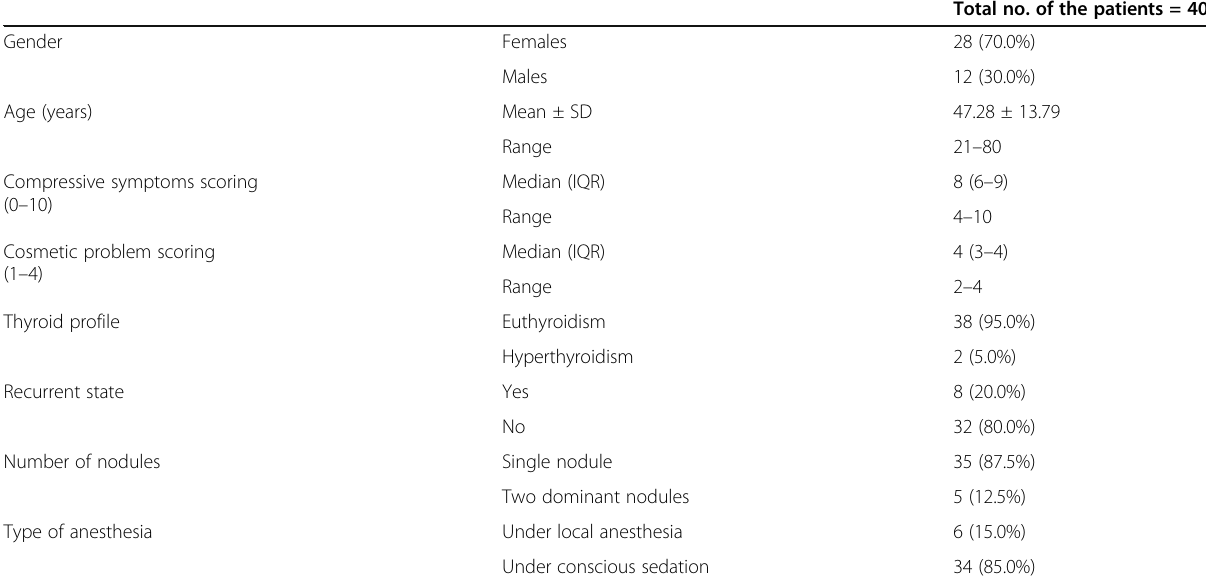
Table 1 Main characteristics and baseline clinical data of the 40 patients